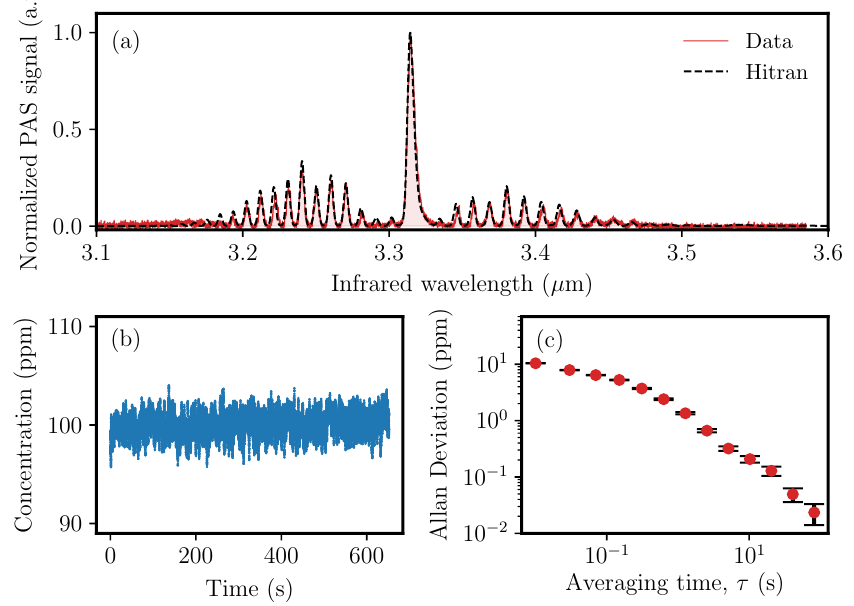
Figure 5. ( a ) Photoacoustic spectroscopic data for 100 ppmV CH 4 in an N 2 -matrix at a pressure of 800 mbar (red) referenced against Hitran data for methane absorption using a Gaussian instrumental profile of 2.5 cm − 1 (black). The stepper-motor scan time is approximately half an hour corresponding to a wavelength scanning speed of 0.3 nm s − 1 . ( b ) Time data when the OPO is locked to the the Q-branch absorption peak at 3.32 µ m. The standard deviation is 1 ppm. ( c ) The corresponding Allan deviation shows that the detection limit for methane is 23 ppbV (nmol/mol) for 82 s of integration